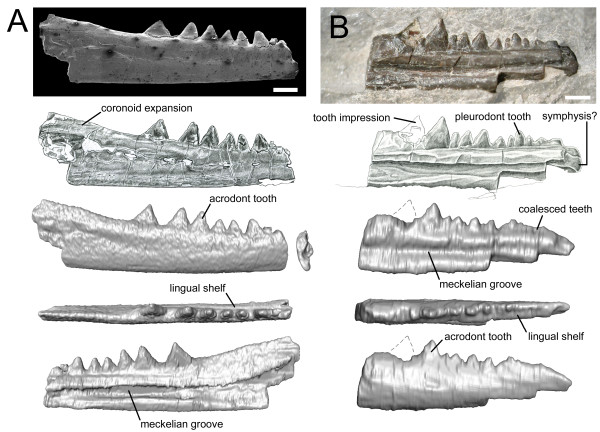
Partial rhynchocephalian dentaries from the Vellberg locality of Germany. A. Dentary SMS 91060. From top to bottom: SEM of labial aspect, drawing of labial aspect, CT model in labial, dorsal and lingual view. B. Dentary SMS 91061. From top to bottom: photo of lingual aspect, drawing of lingual aspect, CT model in lingual, dorsal and labial view. Scale bars equal 1 mm.